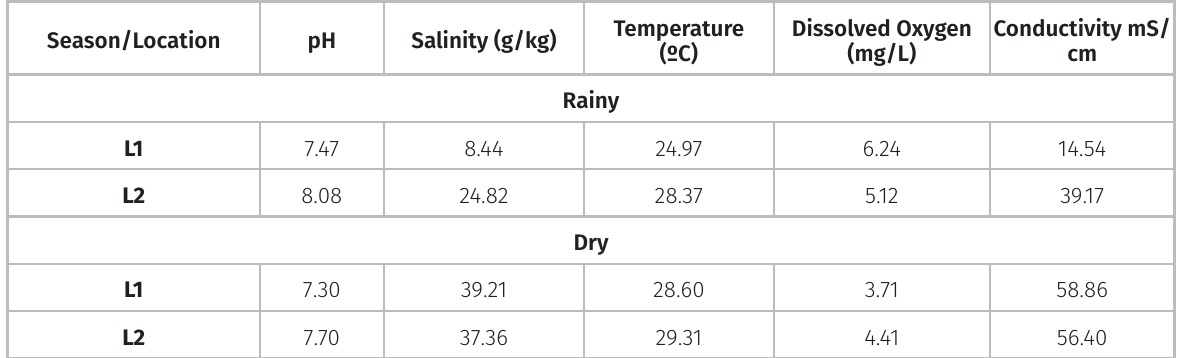
Table I. Physical and chemical characterization of surface water at the reference site, distant from ports and urban centers/industries, and at the vicinity of the Itaqui Port Complex in Maranhão state, northeastern Brazil (dry and rainy seasons,